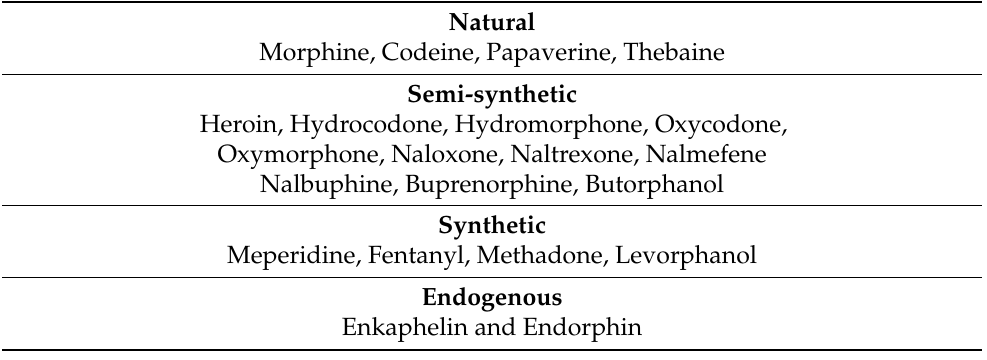
Table 1. Classification of opioids according to source.